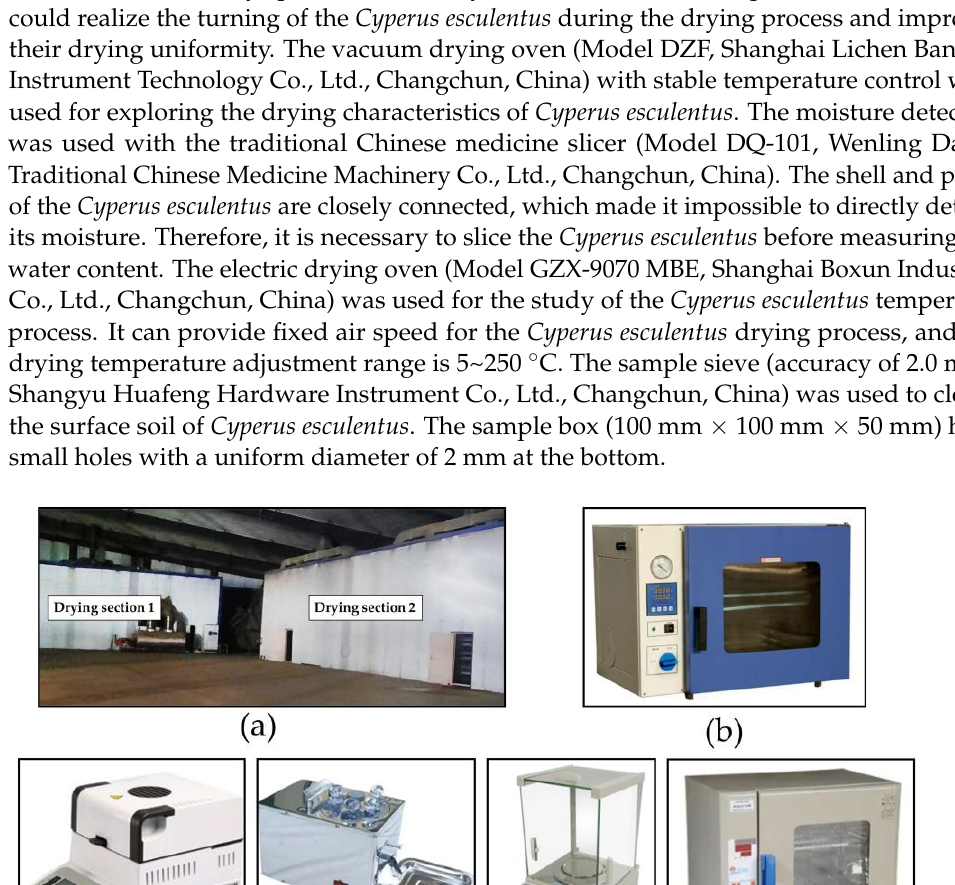
vacuum drying oven; ( c ) moisture detector; ( d ) traditional Chinese medicine slicer; ( e ) electronic